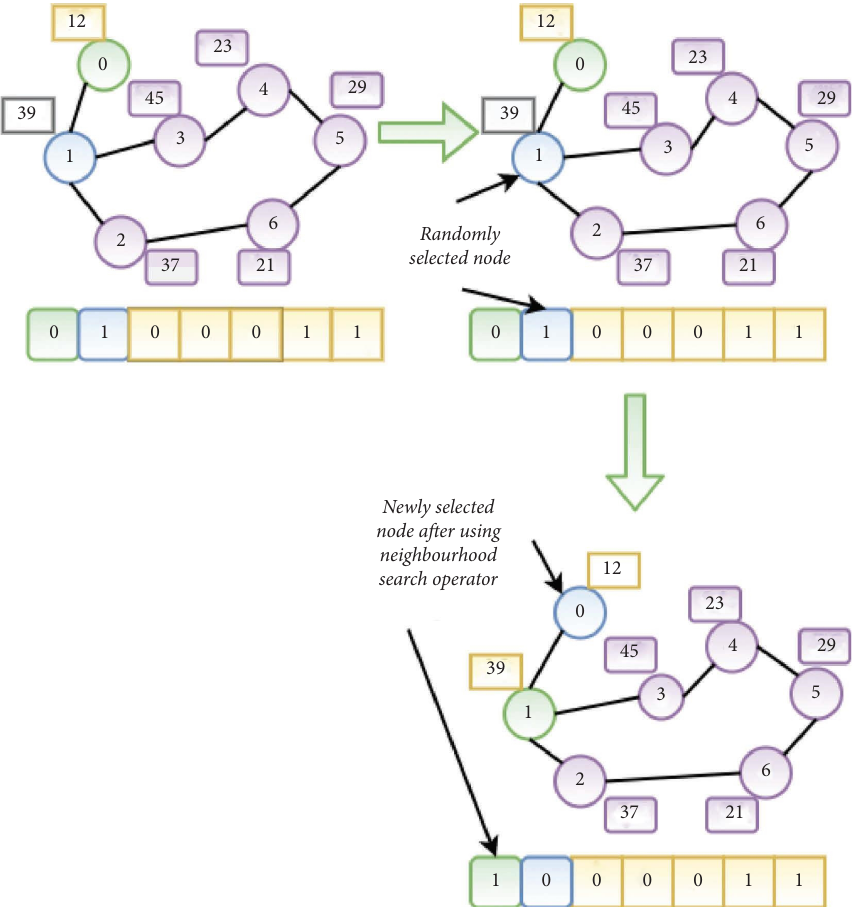
Figure 4: Illustration of a neighborhood search